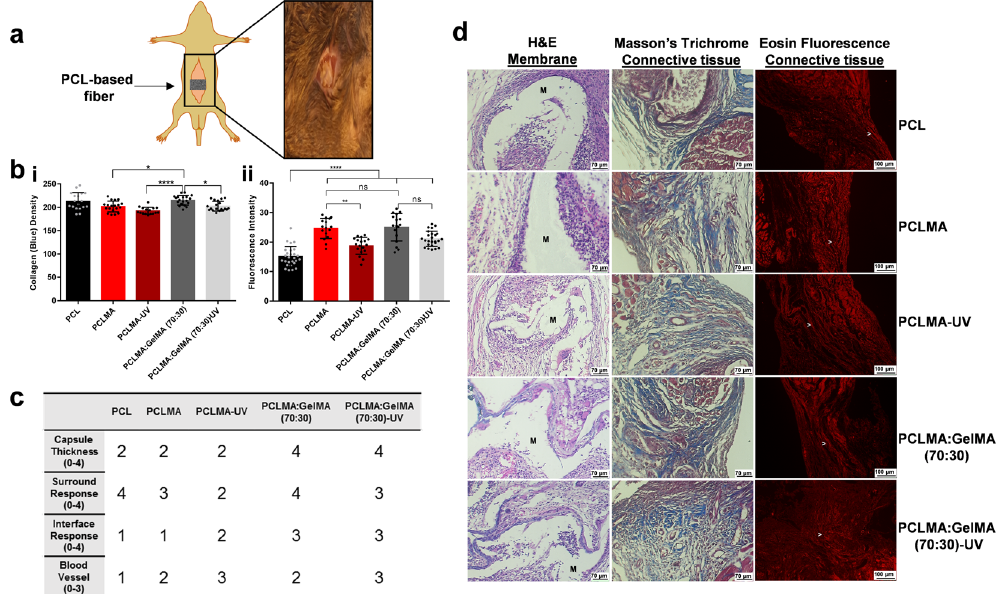
Fig. 6 The in vivo performance of the engineered nano fi bers in a ventral abdominal hernia repair mouse model. a Schematic and picture demonstrating the strategy for the in vivo experiments of abdominal hernia repair. b Quanti fi cation of connective tissue formed as a result of the hernia injury recovery employing the various fi bers after 29 days of implantation. i Total collagen density of the surrounding tissue injury by Masson ’ s Trichrome analysis and processed by ImageJ software. ii Stretch fi ber amount distinguished by eosin fl uorescence under a 590 – 630 nm fi lter of surrounding tissue injury as processed on ImageJ software. Error bars represents mean ± SD of the mean, N = 3; * p ≤ 0.05, ** p ≤ 0.01, **** p ≤ 0.0001, ns (no signi fi cance). c Scoring table showing subjective data regarding the recovery of the hernia injury treated with the various PCL-based nano fi bers after 29 days of surgery recovery (higher number improve rating). d Histological analysis results after 29 days of implanting the nano fi bers using Hematoxylin Eosin (H&E) showing the material interface tissue distinguishing the in fl ammatory cells and giant multinucleated cells promoting material degradation and Masson ’ s Trichrome and Eosin Fluorescence which both distinguish connective tissue (blue and red respectively) on the surround tissue. Membrane (M = Fibers) and stretch fi bers (white